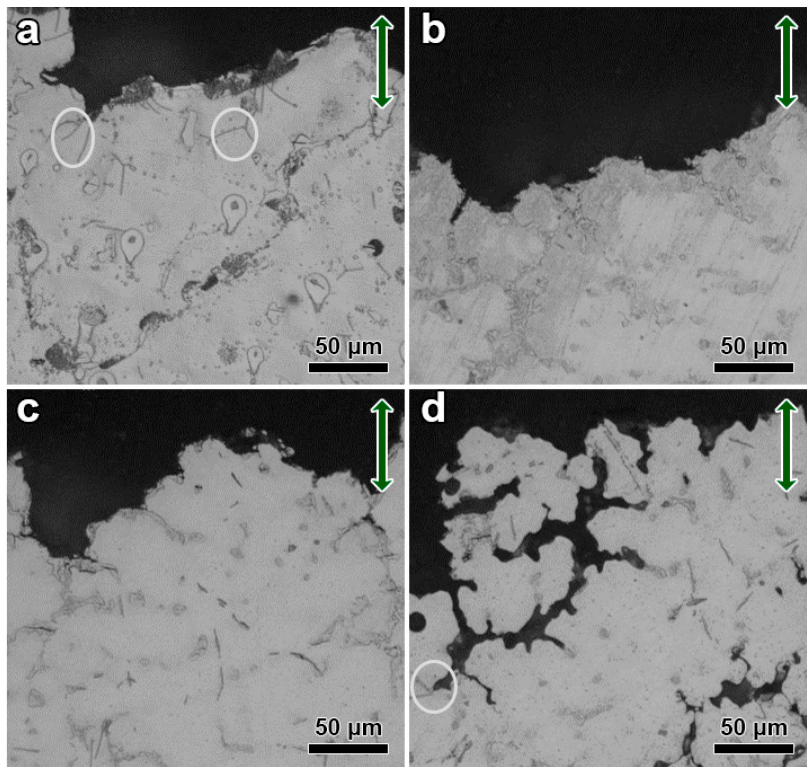
Figure 9. Tensile fracture morphology of longitudinal sections of ( a ) AZ91, ( b ) AZ91–0.5La, ( c ) AZ91– 1.0La and ( d ) AZ91–1.5La; the load directions are marked by double arrowheads in each image,